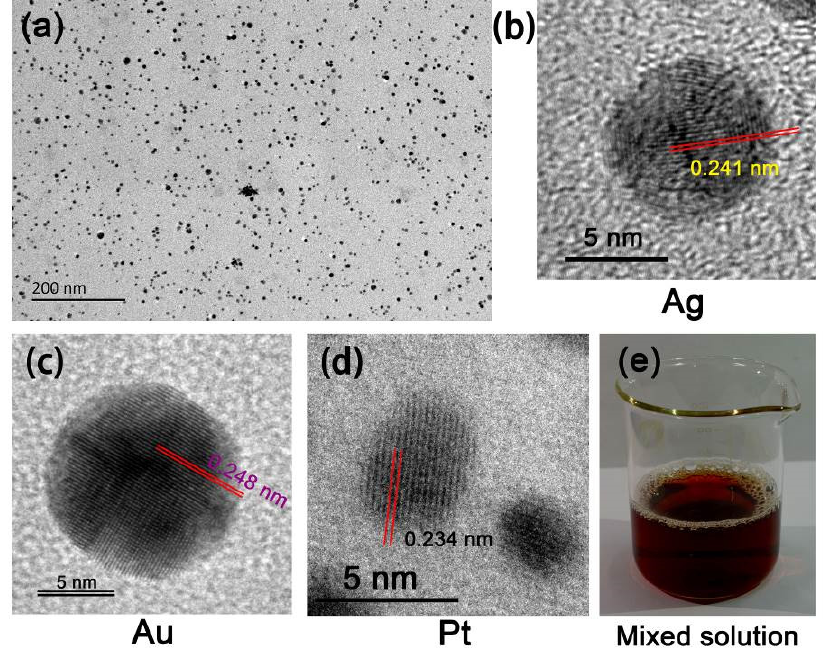
Figure 2. ( a ) TEM and high-resolution TEM photographs of the ( b ) Ag, ( c ) Au, and ( d ) Pt NPs. ( e ) Photograph of the mixed solution.